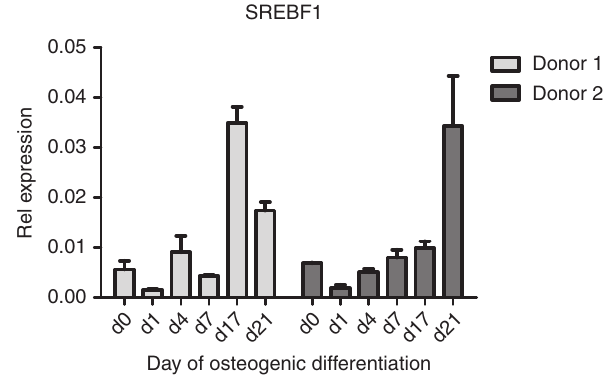
Fig. 4 Expression pro fi le of SREBF1 during osteoblastogenesis. qPCR data of the SREBF1 expression relative to GAPDH in two different donors. Error bars are de fi ned as SD from two technical replicates at each time point.